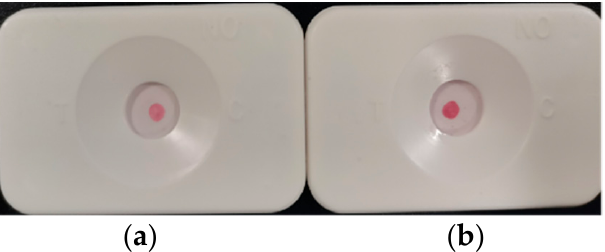
Figure 10. Optimization of SPA content: ( a ) Before optimization (Left); ( b ) Post-optimization (Right).